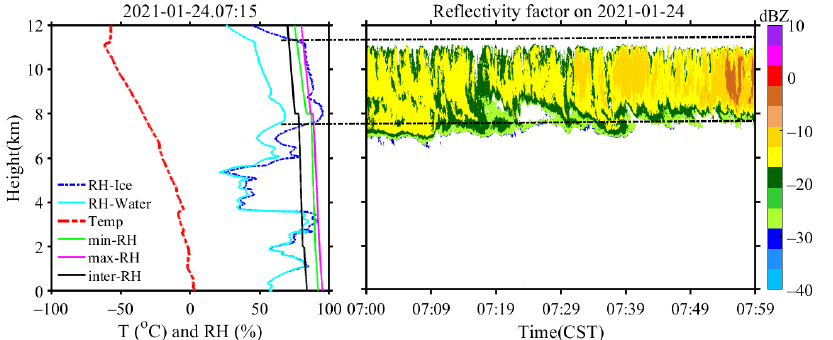
Figure 3. High cloud detected by the radiosonde and MMCR on 24 January 2021 (radiosonde temperature and RH profile ( left ), reflectivity factor THI from the MMCR ( right )).